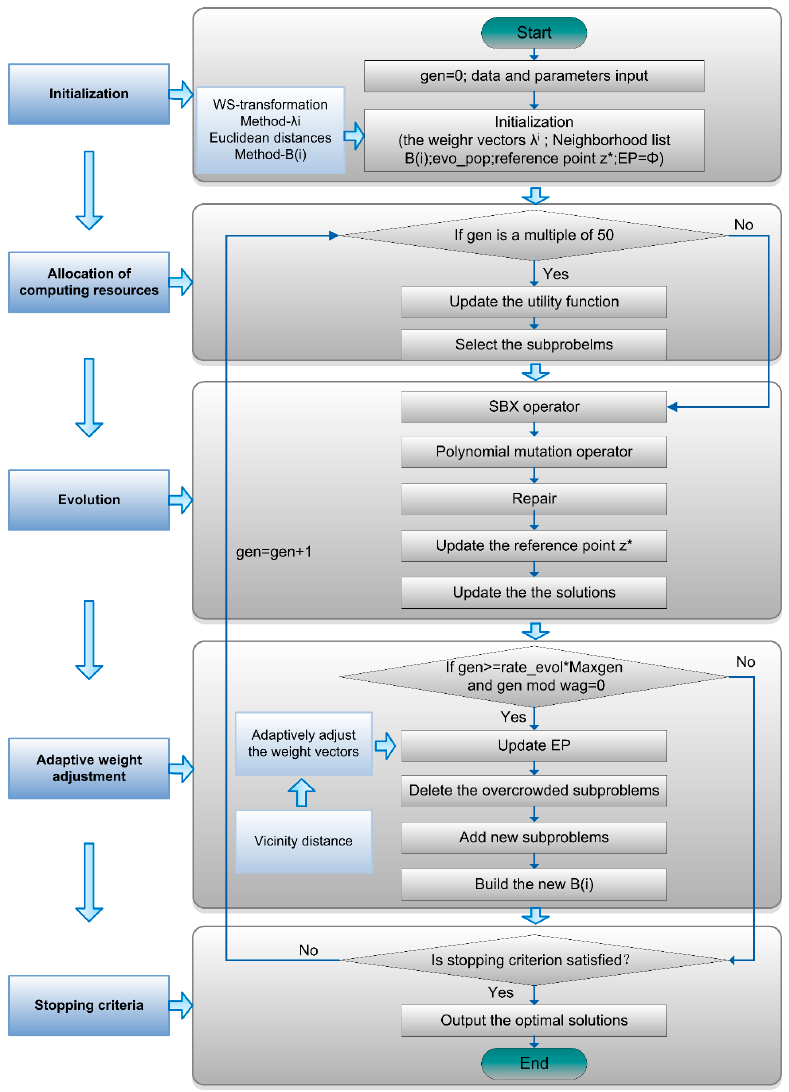
Figure 1. Simplified flow chart of the MOEA/D-AWA.